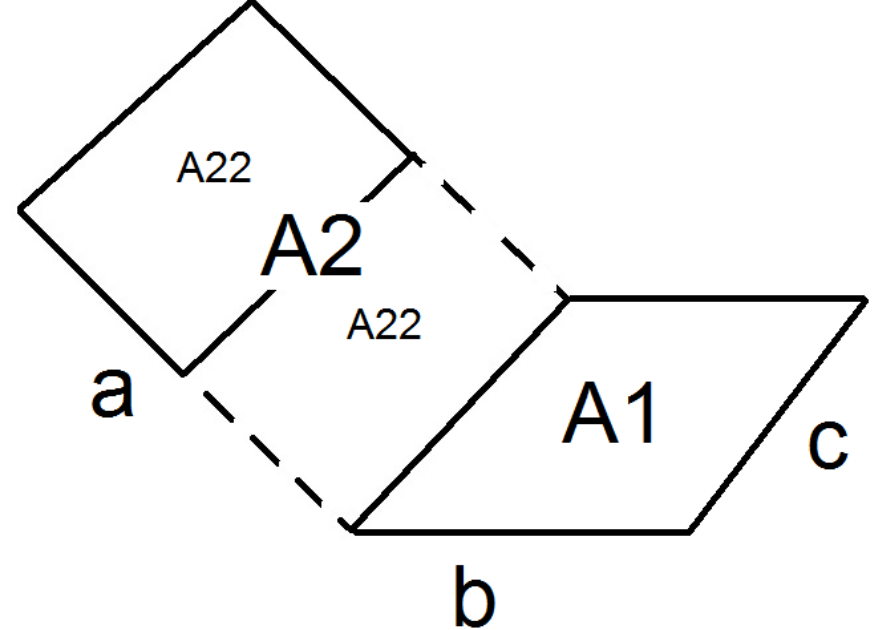
Figure 1. Schematic for the computation of view factor A 1-22 to be incorporated for radiance from surface 1 to surface 22. Note: surface 1 represents the ground and surface 22 the PV module. A 1 = 1, F 1 − 2 = 0.169, F 1 − 21 = 0.151, F 1 − 22 = F 1 − 2 − F 1 − 21 = 0.018.